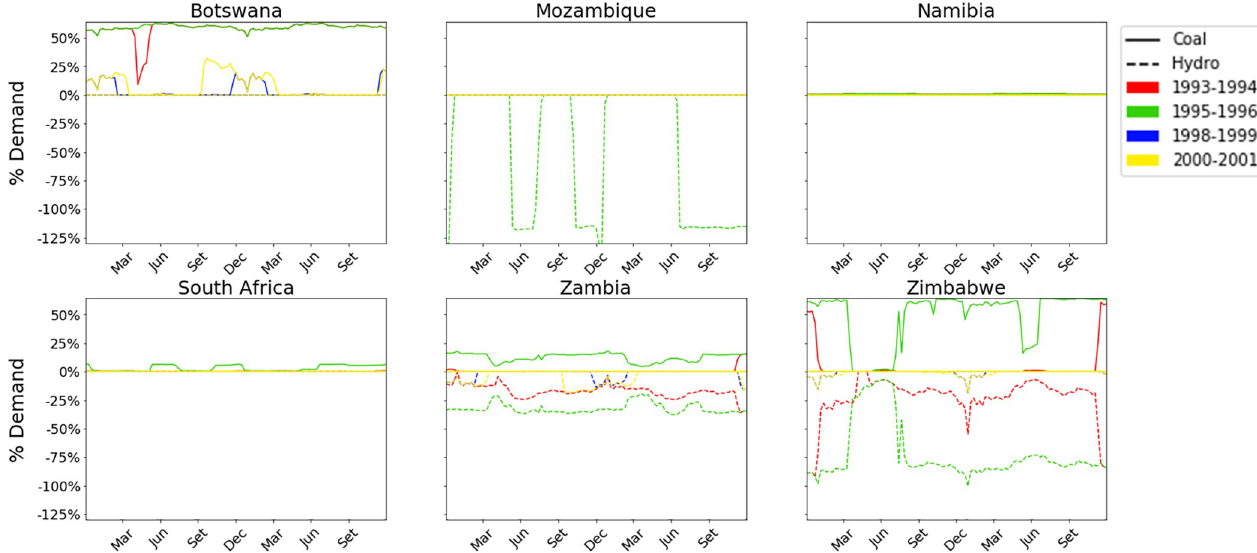
Fig 8. Differential dispatch of the six countries of the power pool, as the difference in power produced between Calliope_Hydro (in the four scenarios) and Calliope_Base , relative to the national electricity demand.